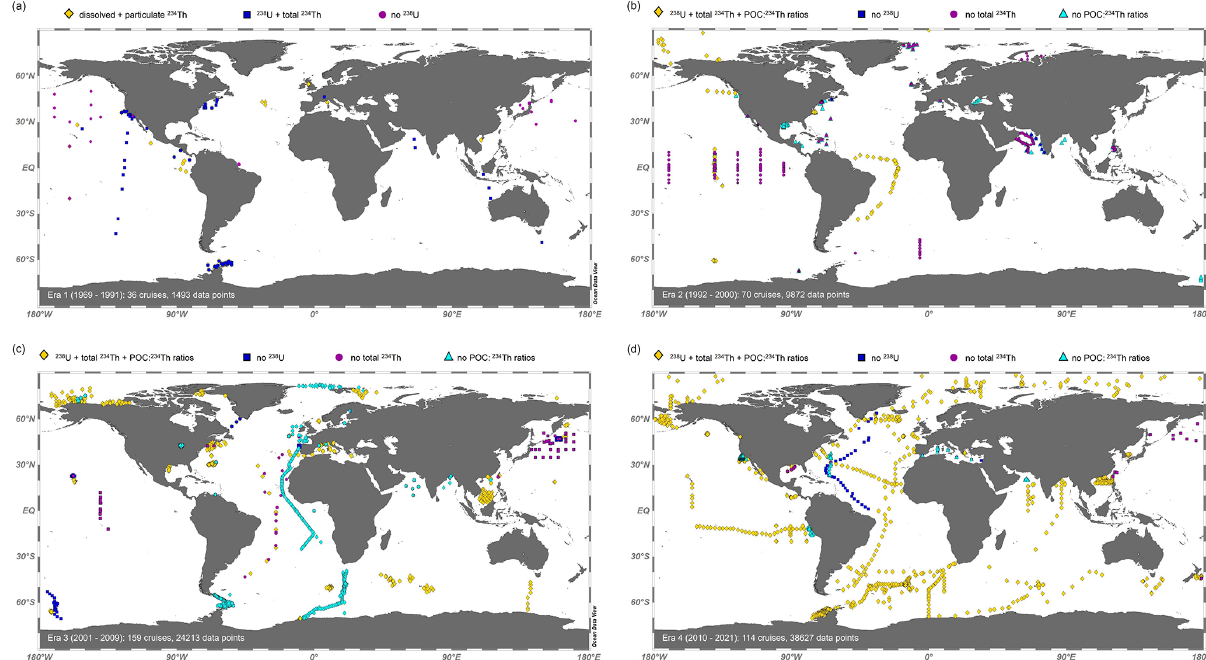
Figure 4. Map showing the distribution of sampling stations reported (a) within era 1 distinguished by the type of data available as follows: (i) dissolved plus particulate 234 Th (yellow diamonds), (ii) 238 U plus total 234 Th (dark blue squares), and (iii) no 238 U (magenta dots); and within eras 2 (b) , 3 (c) , and 4 (d) distinguished by the type of data available as follows: (i) total 238 U plus total 234 Th plus POC : 234 Th ratios (yellow diamonds), (ii) 238 U not sampled (dark blue squares), (iii) total 234 Th not sampled (magenta dots), and (iv) POC : 234 Th ratios not sampled (light blue triangles). The “no parameter” categories mean that from the data shown in the maps – i.e., 238 U, dissolved, particulate, and total 234 Th in panel (a) and 238 U, total 234 Th, and POC : 234 Th ratios from both filtration methods and sediment traps for panels (b) , (c) , and (d) – the “no” category has not been reported by the original authors and therefore is not included in the compilation, but at least one of the other parameters has been reported. Therefore, in panels (b) , (c) , and (d) , only locations that fall into category (i) can be used to estimate POC